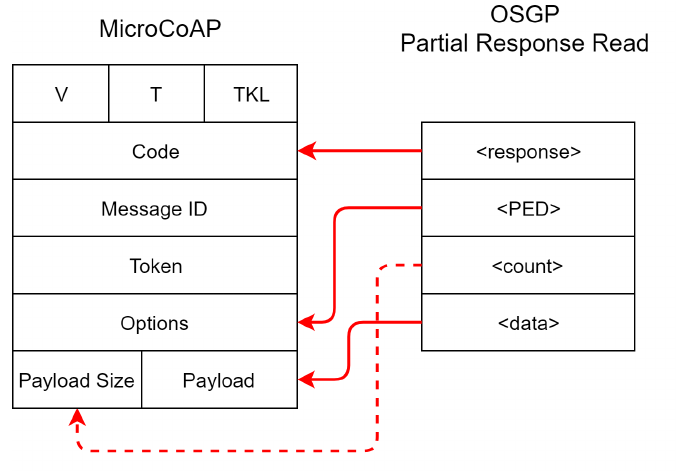
Figure 5. Mapping a response packet from OSGP to CoAP.